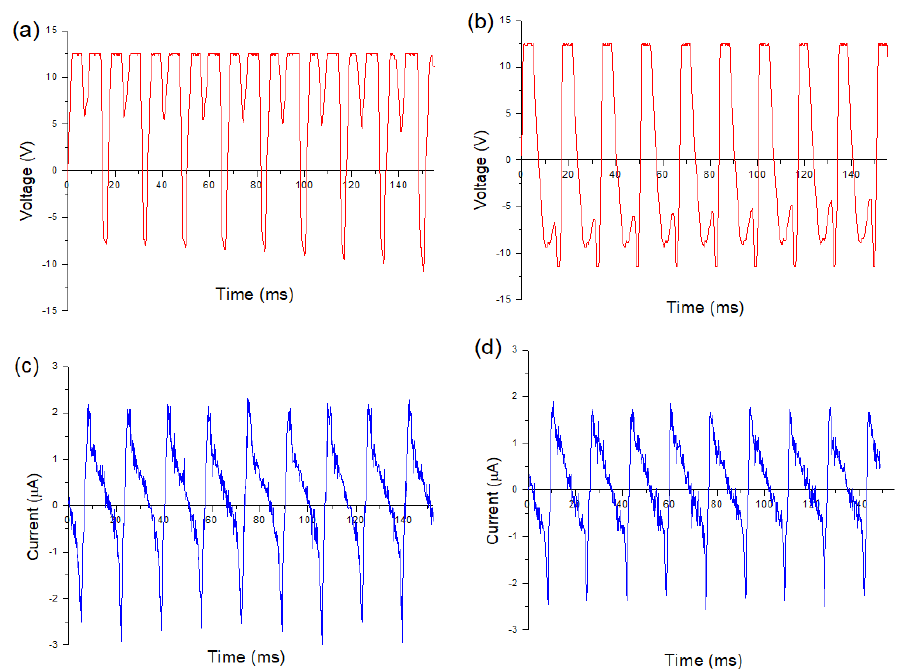
Figure 9. Maximum voltage ( V oc ) and current ( I sc ) generated by a TENG device based on ZnO NRs and PDMS:GO 4% wt at different assembly conditions: ( a , b ) V oc for the device built with and without steel spring, respectively; ( c , d ) I sc for the device assembled with and without steel spring, respectively.